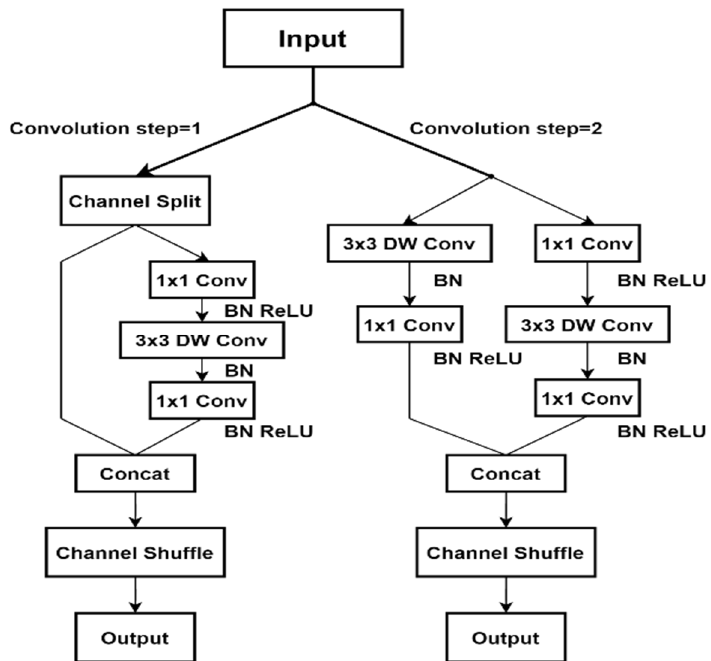
Figure 11. ShuffleNetV2 network structure.